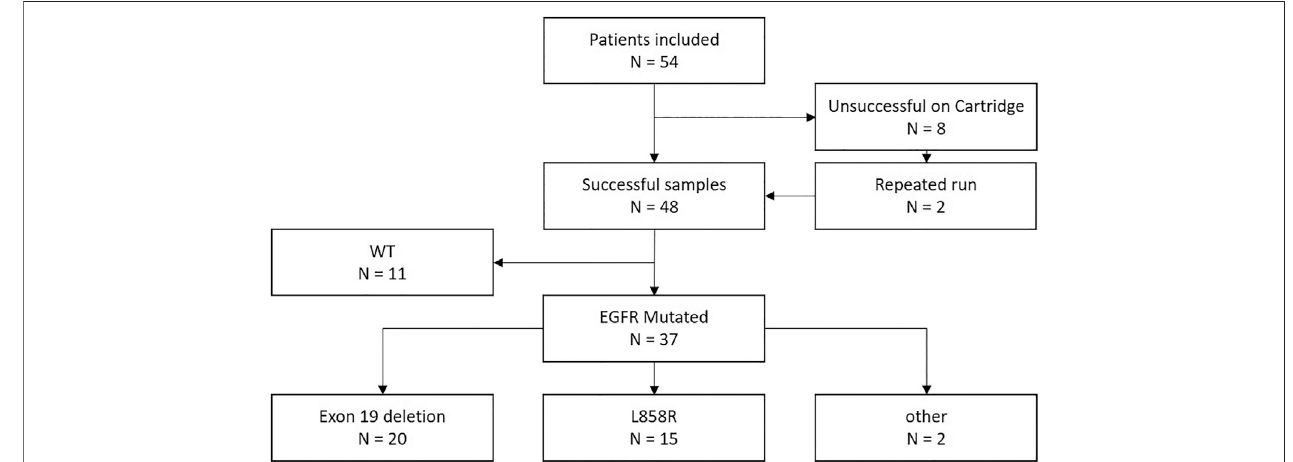
FIGURE 1 | Flowchart of the study.